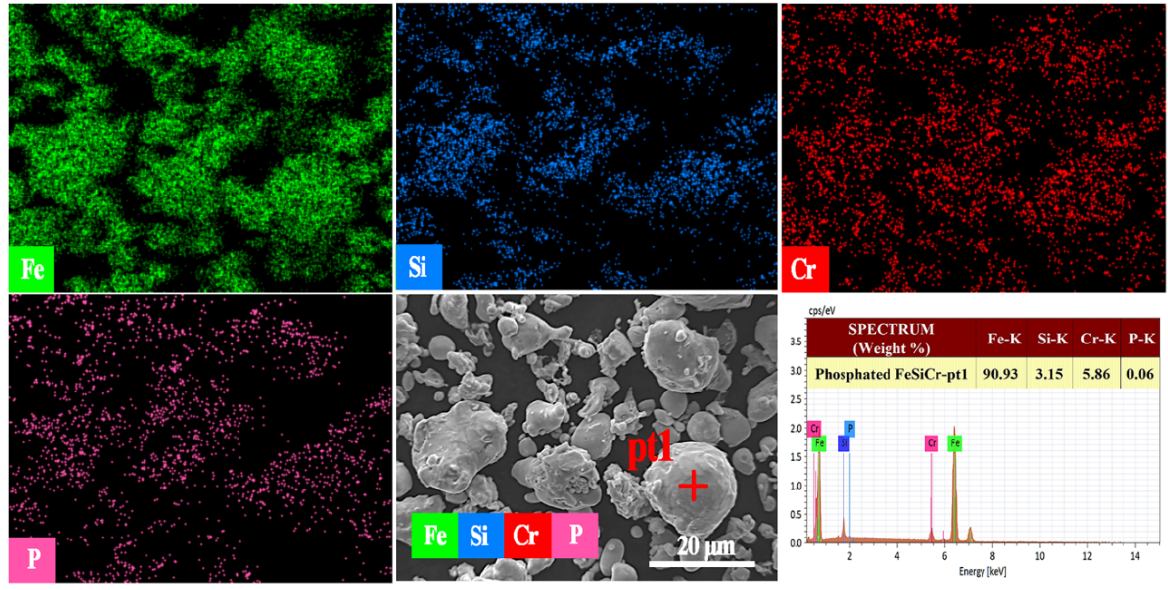
Figure 5. The EDS of Fe-Si-Cr phosphated powder.